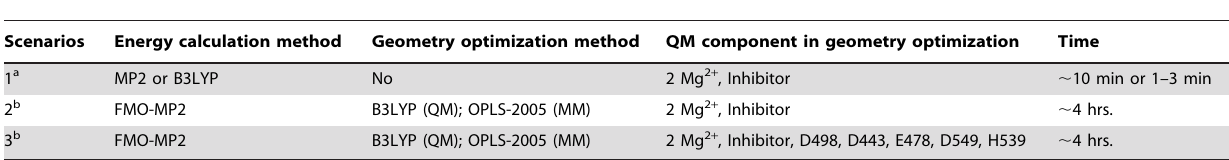
Table 1. Different chelation energy calculation scenarios used in this